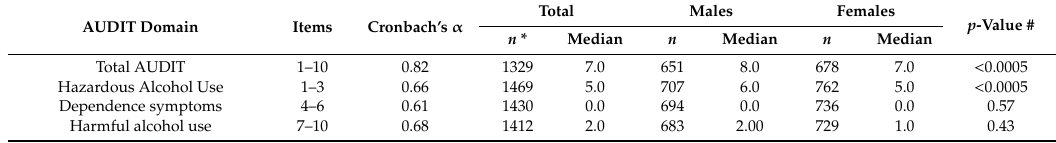
Table 3. Alcohol Use Disorders Identification Test (AUDIT) and sub-domain scores by